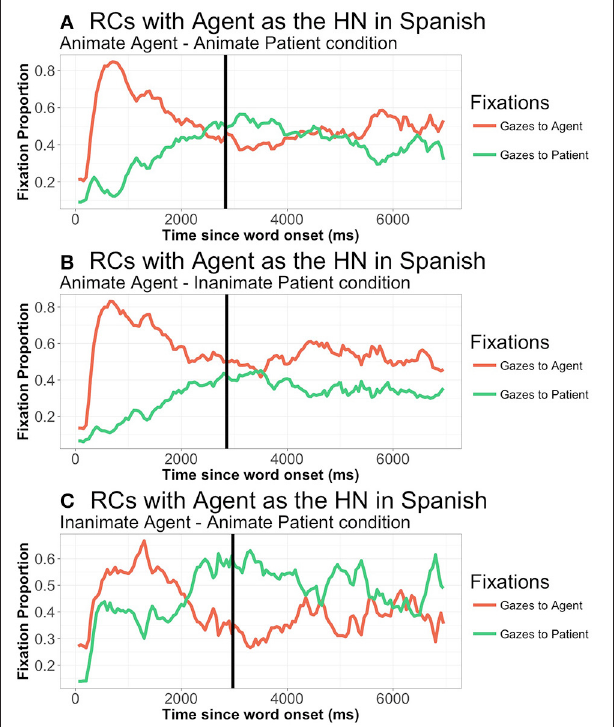
FIGURE 6 | Patterns of gazes to agent and patient in Spanish RCs when the agent was the HN, from picture onset until 7,000ms., in all three animacy combinations: (A) Animate agent—Animate patient; (B) Animate agent—Inanimate patient; (C) Inanimate Agent—Animate patient. Similar pattern when patient was the HN, figures omitted. Vertical line represents speech